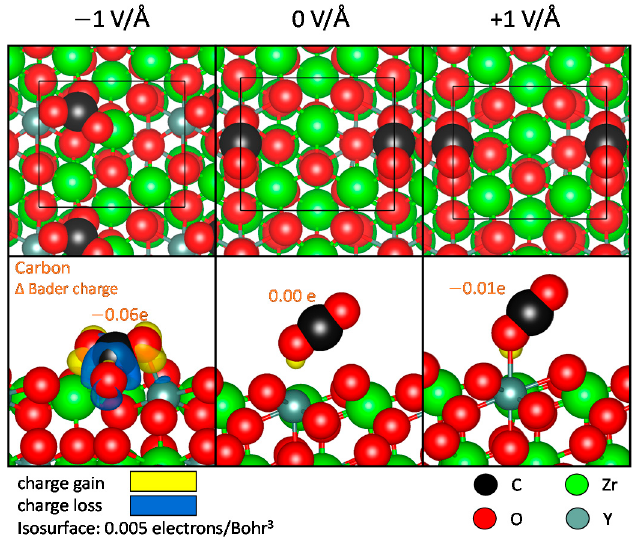
Figure 5. Top and side views of CO 2 adsorption on YSZ (111) under electric fields of − 1, 0, and +1 V/Å. Annotated in orange is the Bader charge difference of carbon (on CO 2 ) with respect to carbon (on CO 2 ) when the field is absent. (on CO 2 ) when the field is